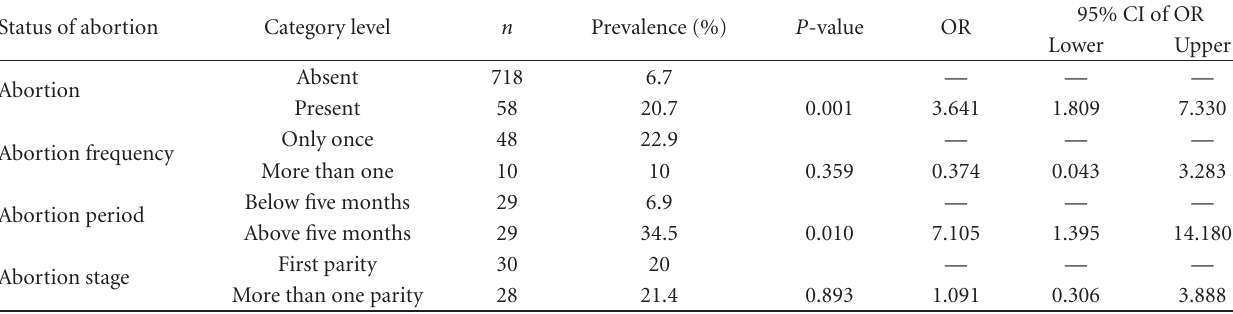
Table 3: Univariable logistic regression analyses of abortion related factors with dependent Brucella seropositivity in cows in Western Tigray, North West Ethiopia, October 2007 to February